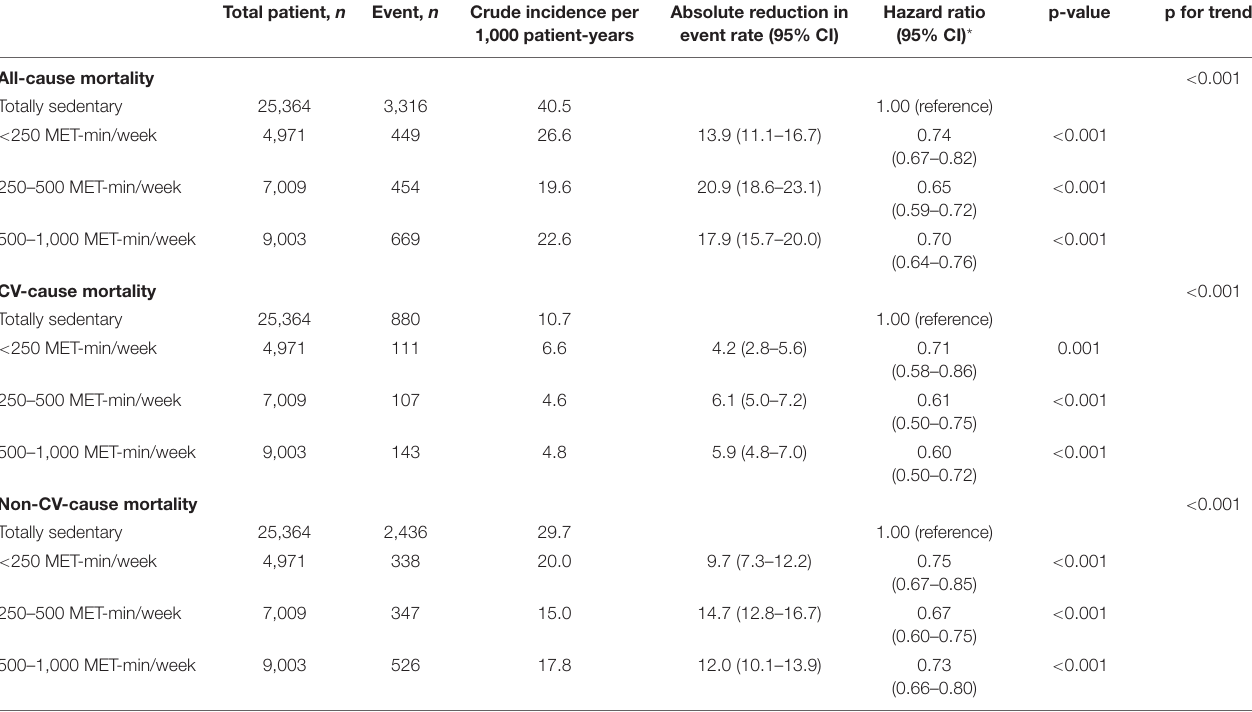
TABLE 3 | Incidence and hazard ratio with 95% confidence intervals for all-cause death, CV cause death, and non-CV-cause death in those who did not perform any activity beyond LPA, according to energy expenditure (MET-min/week). Total patient, n Event, n Crude incidence per Absolute reduction in Hazard ratio 1,000 patient-years event rate (95% CI) (95% CI)